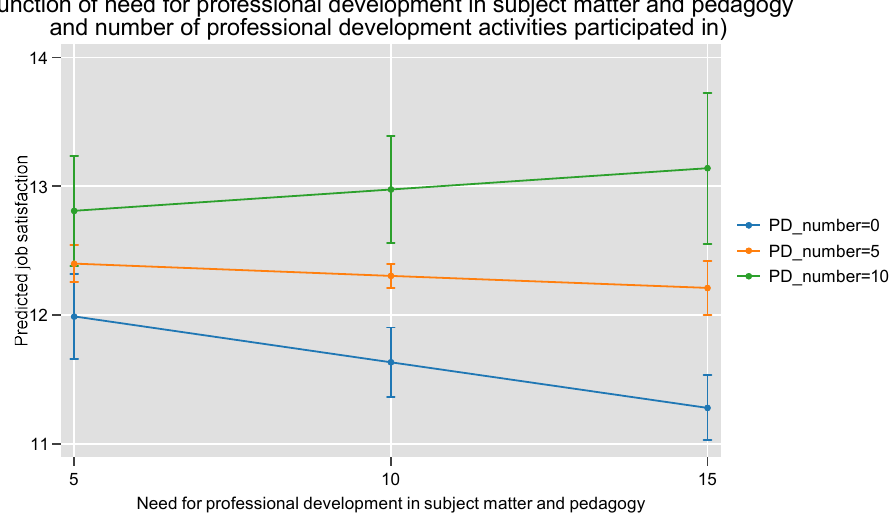
Figure 1. Predicted job satisfaction as a function of the need for professional development for diver- sity and special needs and the number of professional development activities participated in.